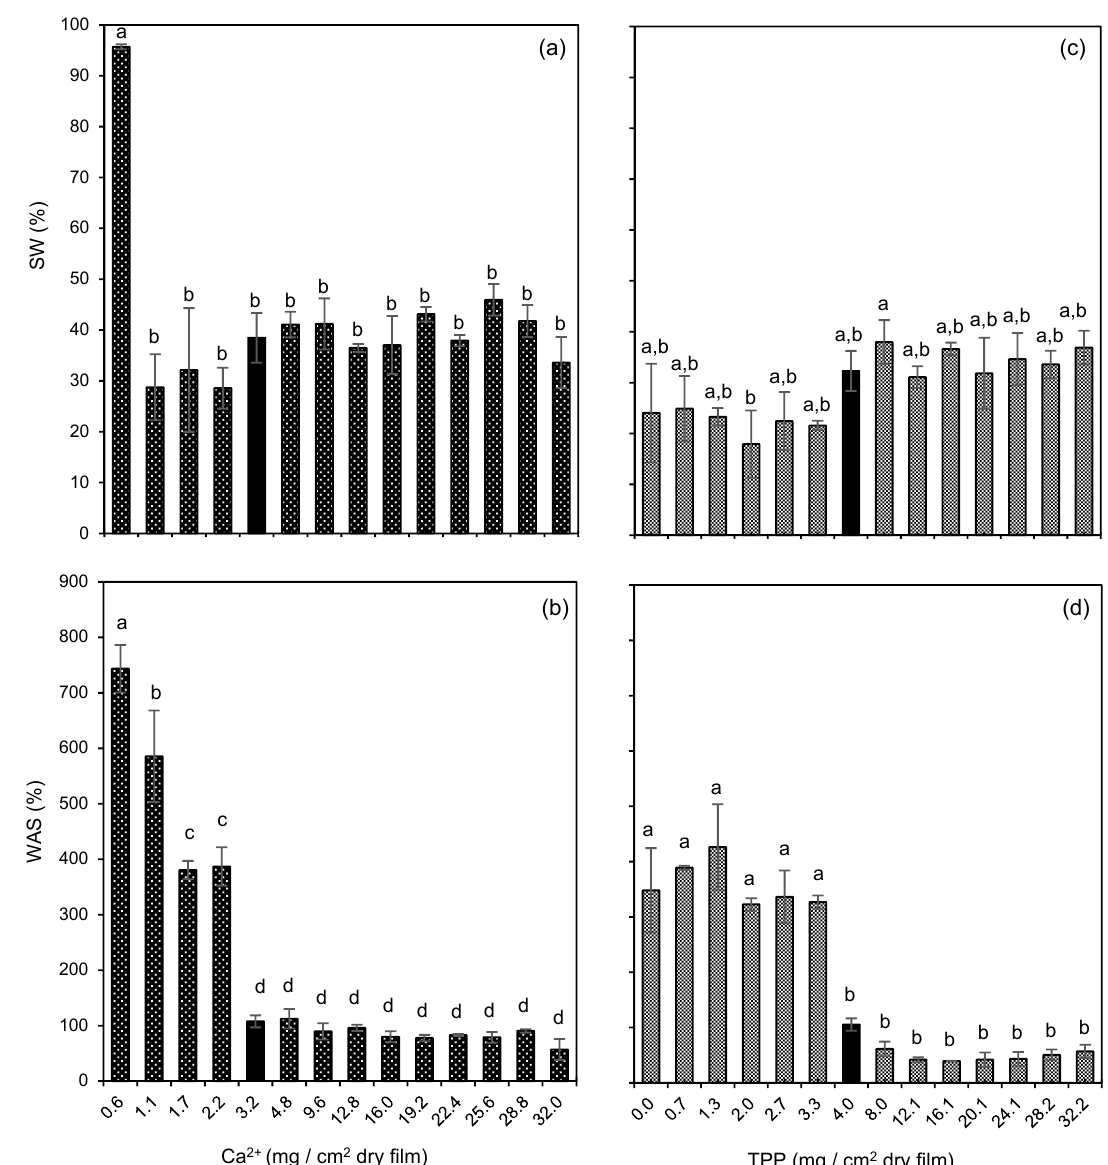
Figure 2. Influence of crosslinker content sprayed on film’s surface on their solubility in water (SW) and water absorption capacity (WAC). ( a , b ) refer to the alginate-emulsion films A-L25O100; ( c , d ) refer to the chitosan-emulsion films C-L25O25. Bars indicate the mean ± standard deviation. Means in bars with different letters are significantly different ( p < 0.05), based on Tukey’s test, separately for each data set from a) to d). Bars in black refer to crosslinking mass selected for the next steps of this study.